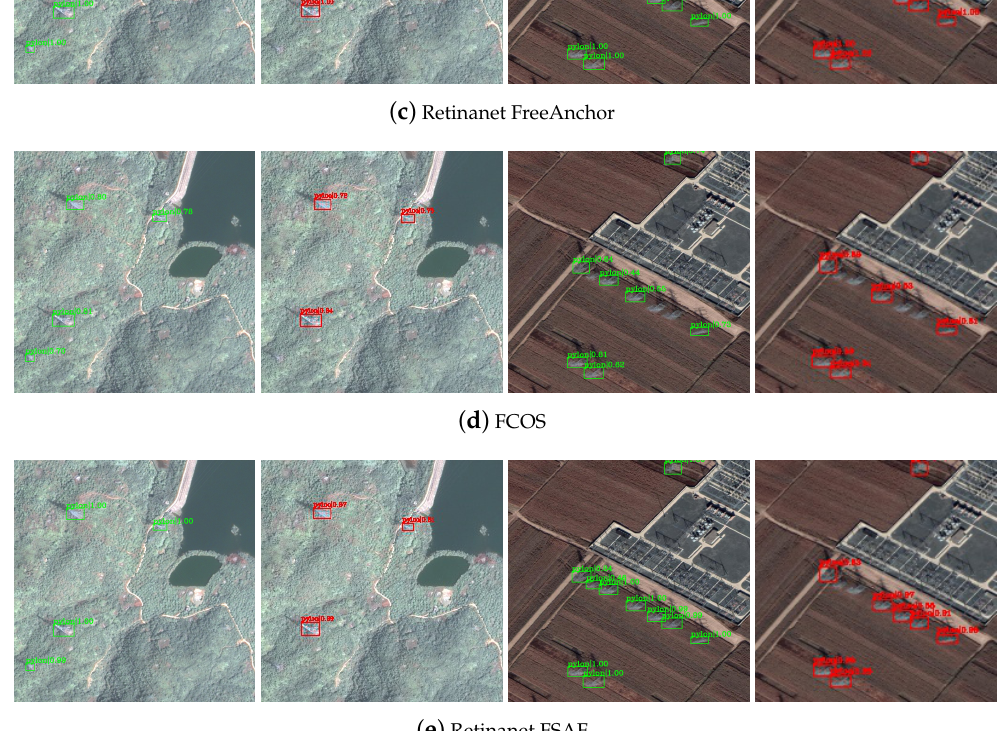
Figure 16. Visualization of experimental results on the EPD-C subset (Continued). We utilized detectors obtained from Section 4.3 to test two scenes in the EPD-C subset. For each scene, the left image is in 1-m resolution, while the right one is in 4-m resolution. Rows ( a – e ) show detection results of YOLOv3, YOLOv4, Retinanet FreeAnchor, FCOS, and Retinanet FSAF, respectively. We use the green detection boxes in the 1-m images and the red detection boxes in the 4-m